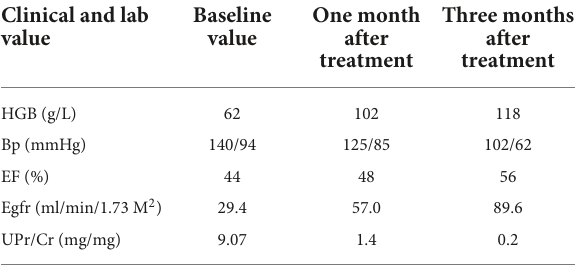
TABLE 1 The changes of clinical and lab value before and after treatment. Clinical and lab